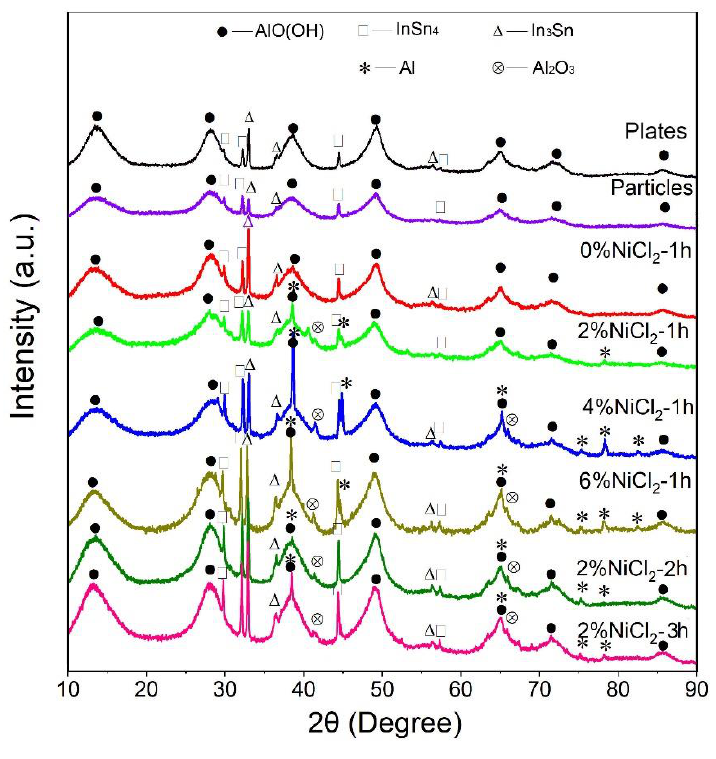
Figure 7. XRD patterns of the by-products of Al-LMPM and Al-LMPM composites reacting with tap water.